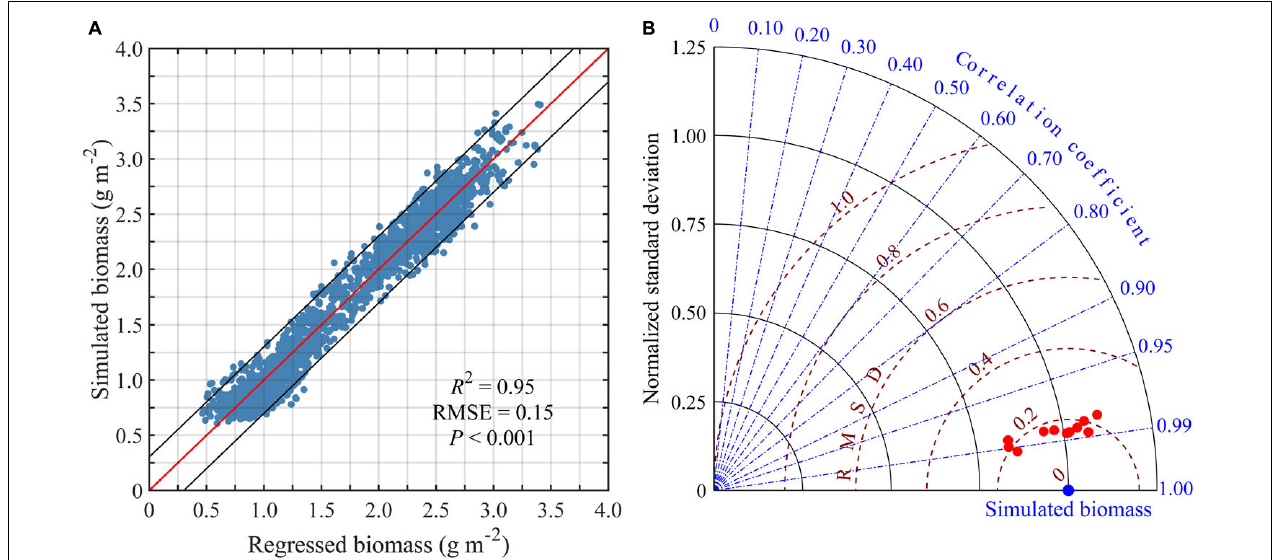
FIGURE 7 | Comparison between the regressed and the simulated biomass of the Yesso scallop ( P. yessoensis ) in the Changhai sea area, China. The correlations between the regressed and the simulated biomass from December 1, 2006 to November 30, 2017. The red solid line is the regression line and the black solid line is the 95% confidence interval (A) . Taylor diagram comparing regressed biomass (red dot) and simulated biomass (blue dot) from December 1, 2006 to November 30, 2017. The radial distance from the origin is proportional to the ratio of regressed and simulated biomass standard deviations (gray solid curves), and the azimuthal position corresponds to the correlation between regressed and simulated biomass (blue dashed lines). The distance from each regressed value to the simulated value is proportional to the normalized root mean square deviation (RMSD) between the simulated and regressed biomass (red dashed curves) (B) .